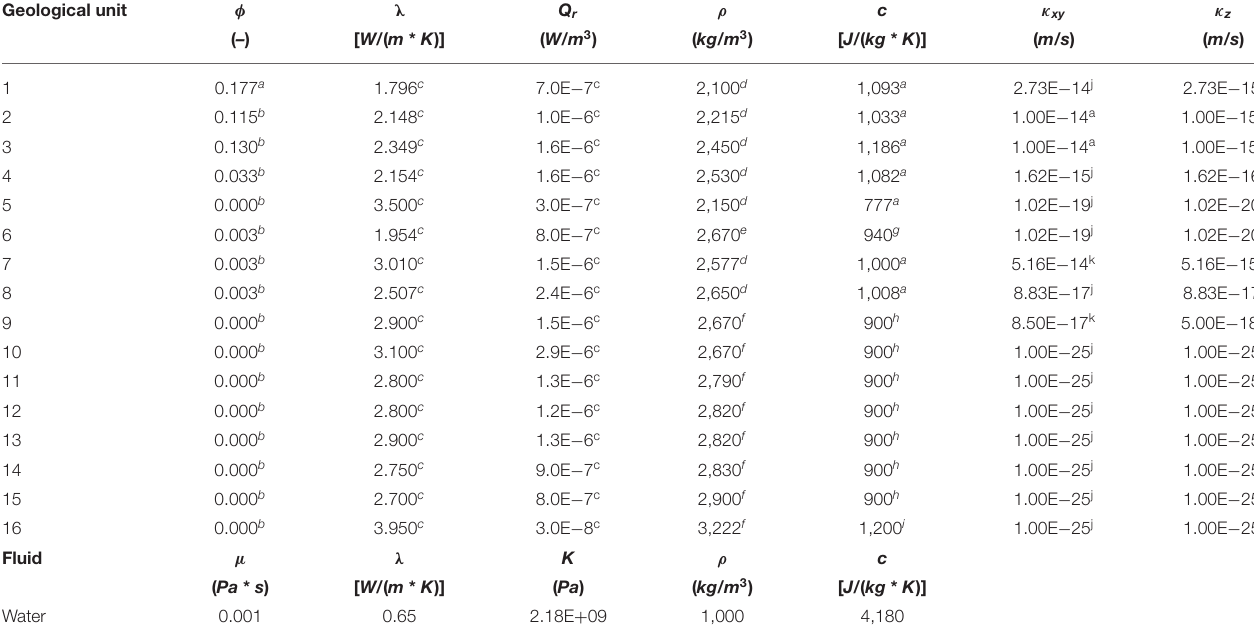
TABLE 1 | Physical properties of the model units and water as used for the numerical simulations. Geological